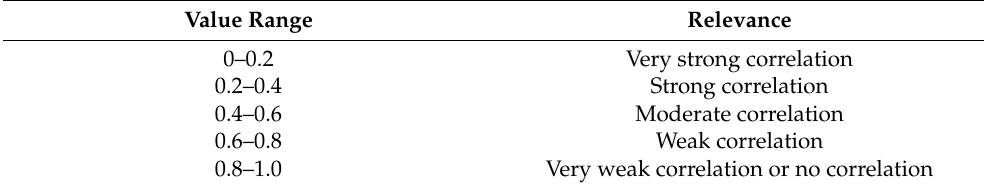
Table 1. Pearson correlation coefficient intervals and correlation